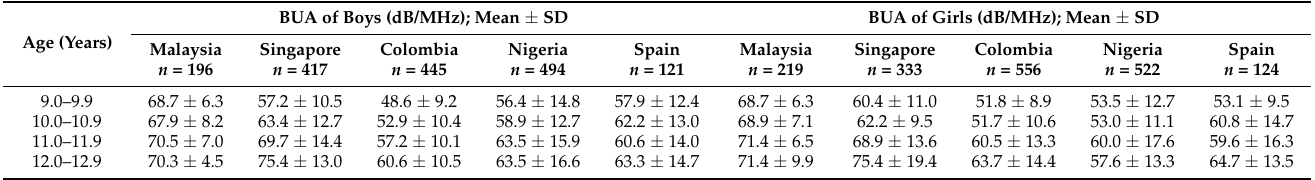
IqR: interquartile range; SD: standard deviation; WC: waist circumference; BMI z-score: body mass index-for-age z-score; BUA: broadband ultrasound attenuation; ⸸ Mann-Whitney test; ⸸⸸ Independent t-test; * Significant at the 0.05 level; *** Significant at the 0.001 level.